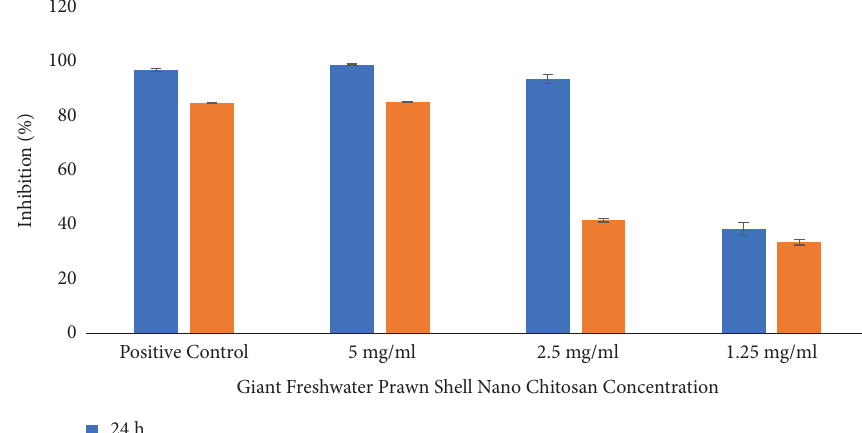
Figure 1: Te efects of various concentrations of PSNC on bioflm formation. Te bioflm formation inhibition percentage increased with an increase in the concentration of PSNC. Data were calculated from four independent assays and reported as the average; the standard deviations are